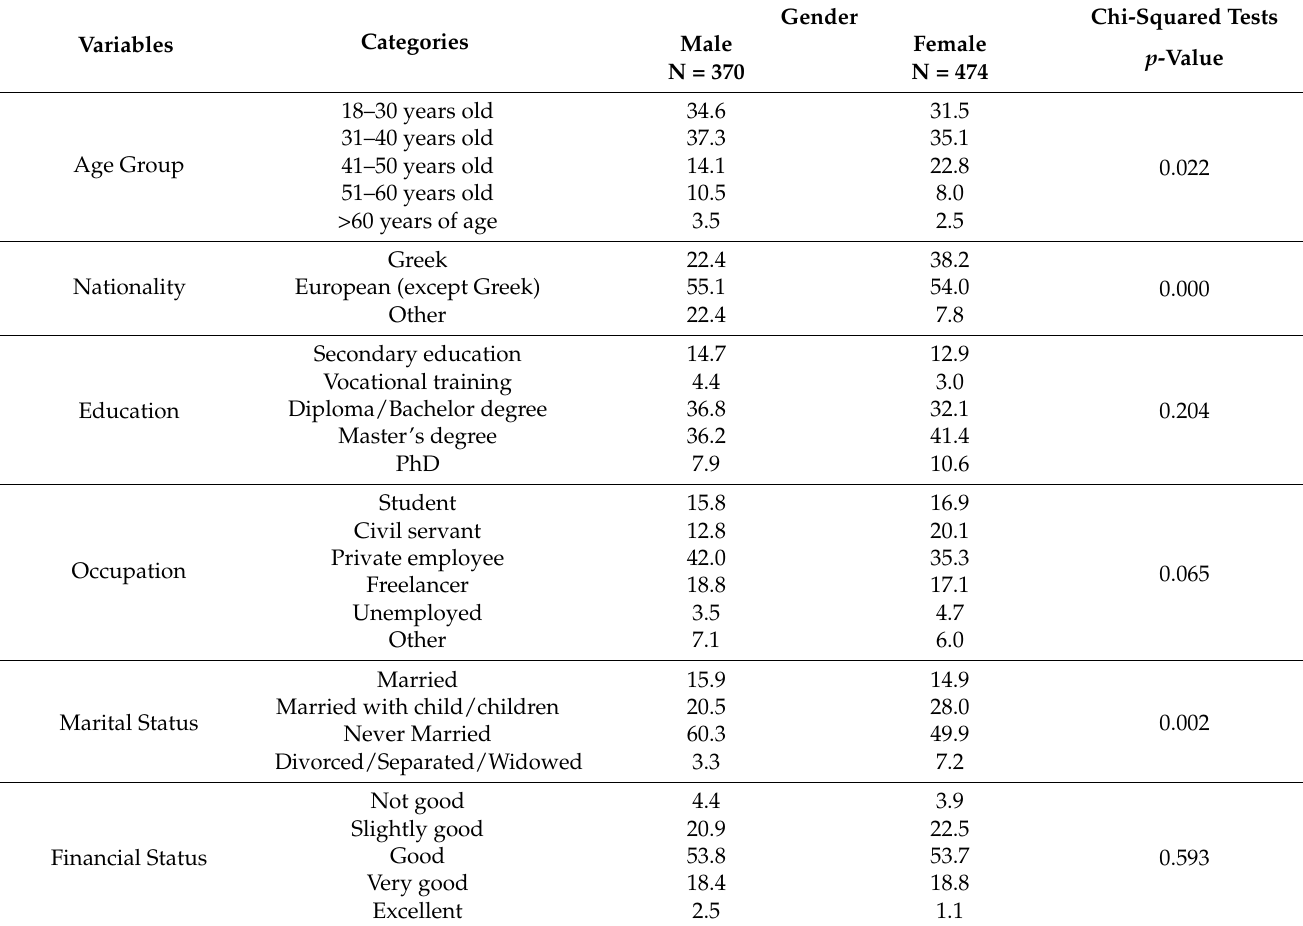
Table 1. Distribution of tourists’ socio-demographic profile in terms of